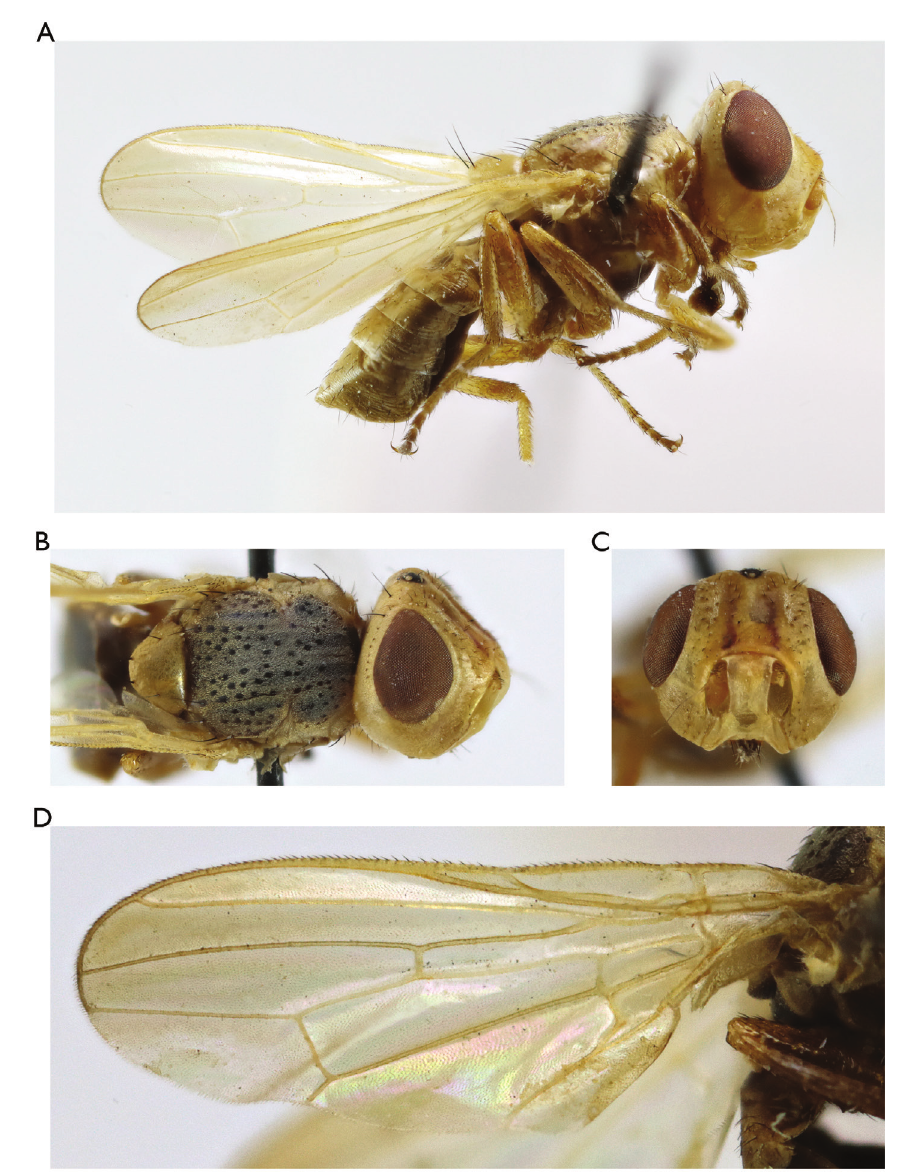
Figure 11. Timia zaitzevi Galinskaya 2011, paratype male A habitus, lateral view B head and thorax, dorsal view C head, anterior view D wing.